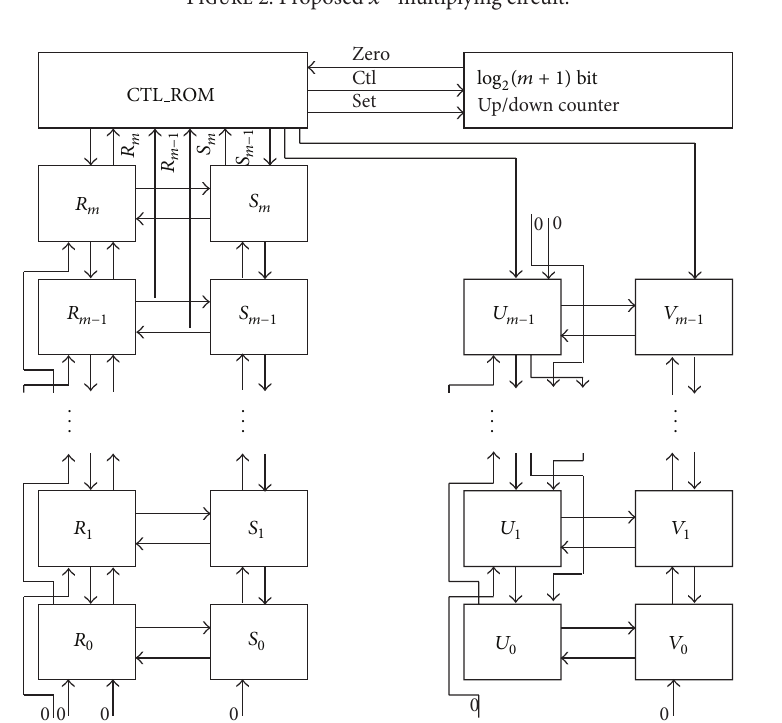
Figure 3: Block diagram of GF( 2 𝑚 ) divider with